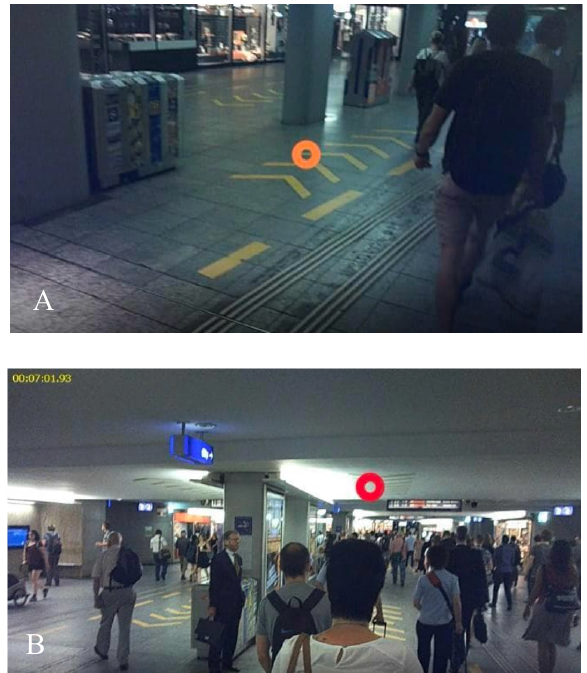
Figure 4. Approximately two thirds of the participants look at the signs on the floor (A), one third at the signs on the ceiling (B).